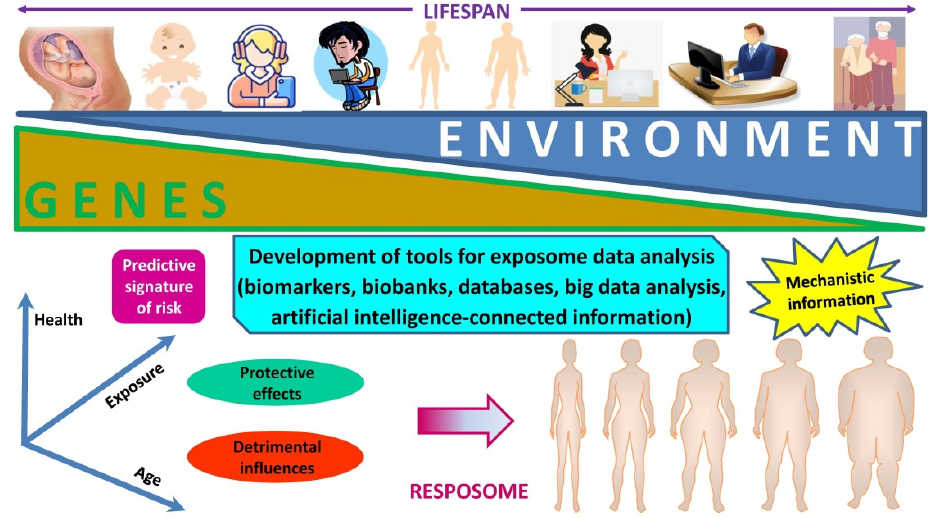
Figure 5. Evolution of the individual’s genetic and environmental framework across the lifespan. Over a lifetime, genetic and environmental influences may change reciprocally with acute and chronic exposures translating into a specific information with predictive interest as well as effective biomarkers that may provide mechanistic insight of pragmatic application.